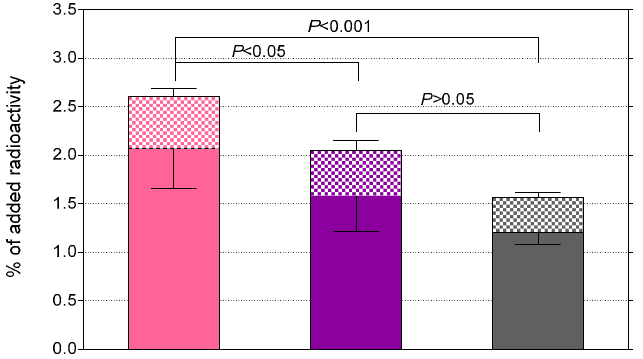
Figure 3. Specific uptake of [ 99m Tc]Tc-DB7 (pink bars), [ 99m Tc]Tc-DB13 (violet bars) and [ 99m Tc]Tc-DB14 (gray bars) in PC-3 cells after 1 h incubation at 37 °C (checkered bars: internalized, solid bars: membrane bound fractions); results represent the mean ± SD of 3 experiments performed in triplicate.